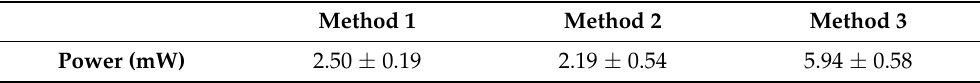
Table 2. Measured results by three different